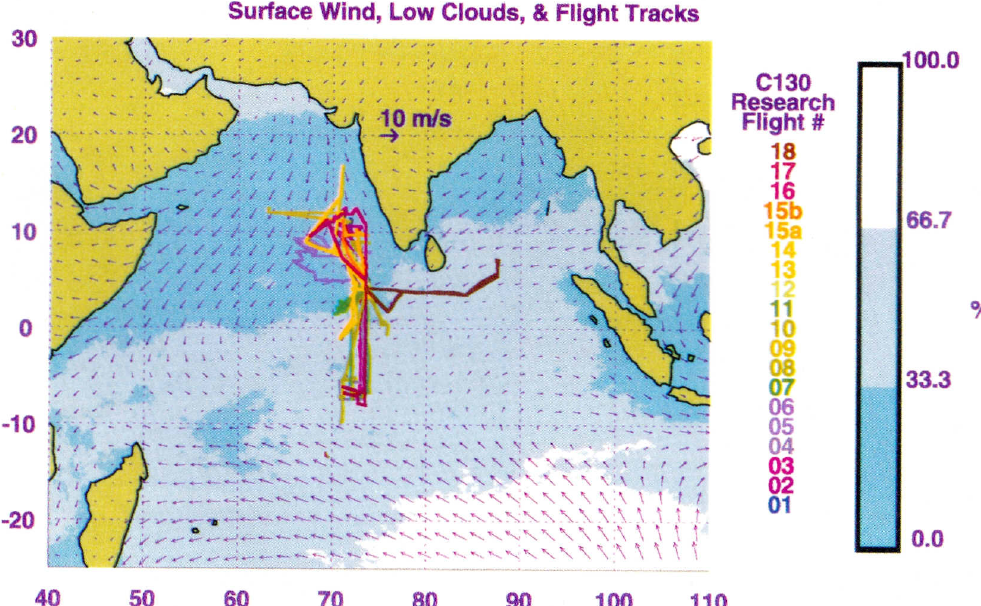
Fig. 12. Flight tracks of the NCAR C-130 during the INDOEX intensive field phase (IFP), overlaid on the mean surface wind data from the NCEP/NCAR reanalysis (from Ramanathan et al., 2001, copyright 2001 by the American Geophysical Union, reproduced with